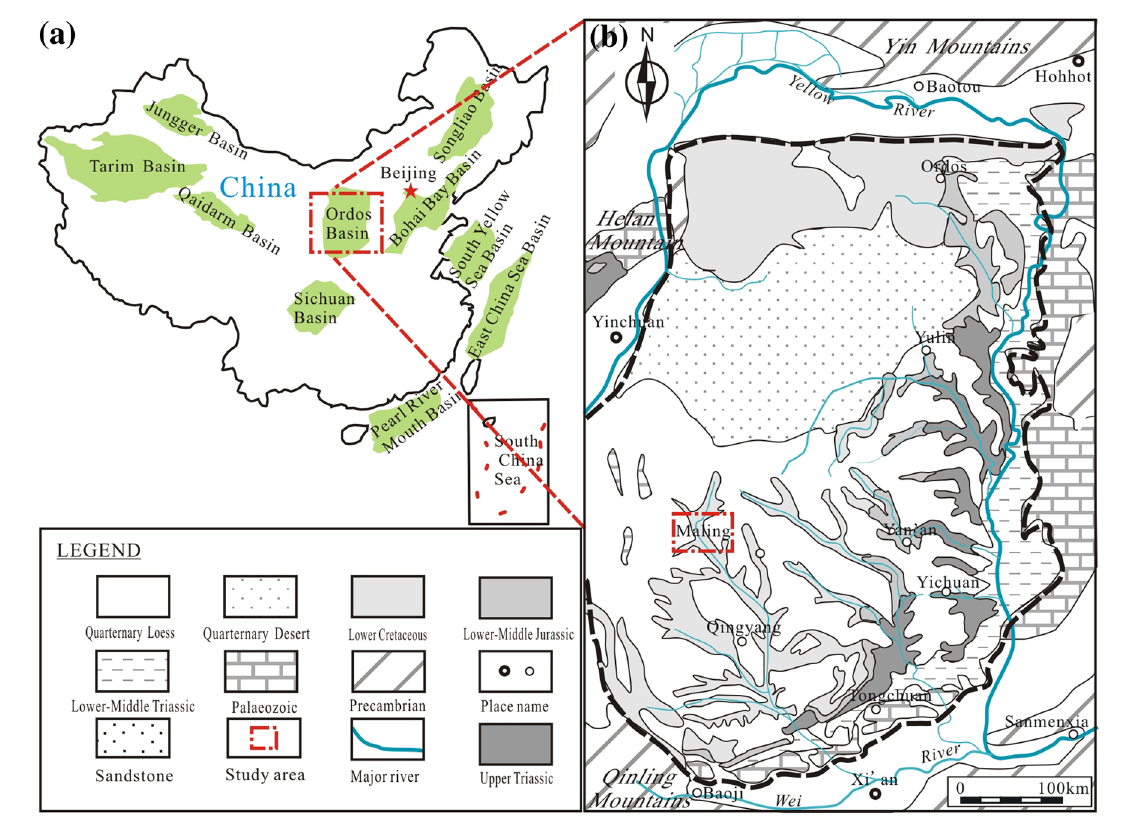
Fig. 1 Geographic location of Maling Oilfield ( b ) in the Ordos Basin ( a )